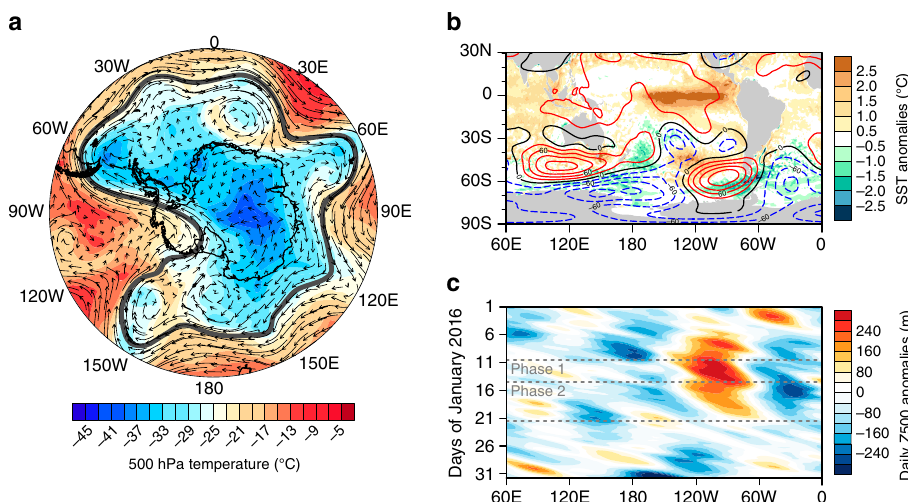
Figure 5 | Atmospheric circulation associated with the January 2016 melt event. ( a ) Map showing the air temperature (shaded) and wind vectors at 500hPa at 00 UTC on 12 January 2016 based on ERA-Interim. The thick black line outlines the 5,300 meter geopotential height contour separating cold polar air masses from warmer mid-latitudes air masses. ( b ) Sea surface temperature anomalies (shaded) overlaid with ERA-Interim 500hPa geopotential height (Z500) anomalies (contour lines) in January 2016. Solid red, dashed blue and solid black contour lines represent (respectively) positive, negative and zero Z500 anomalies. Anomalies are calculated with respect to the 1971–2000 period. ( c ) Hovmo¨ller diagram showing daily meridionally averaged Z500 anomalies within latitudes 50–80 (cid:2) S during January 2016. The anomalies are with respect to the 1979–2016 January monthly mean.